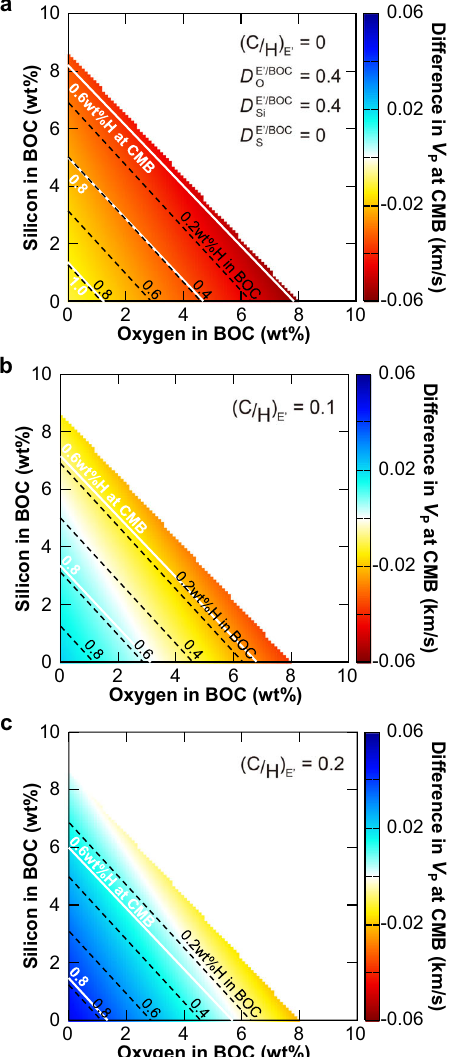
Fig. 4 Difference in P -wave velocity ( V P ) between S-rich bulk outer core (BOC) and H-rich E ′ layer. Colored areas show compositional ranges that explain the density and velocity of the BOC with Si, O, H, and 2 wt% S. The difference in V P of the E ′ layer from the BOC at the core-mantle boundary (CMB), and the hydrogen contents in the BOC (black dashed line) and at CMB (white solid line) are given as functions of Si and O in the BOC. These calculations assume the C/H molar ratio in the E ′ layer to be 0 in a , 0.1 in b , and 0.2 in c . The dark orange color indicates the V P difference by − 0.035 km/s that is supported by seismological models 41 – 43